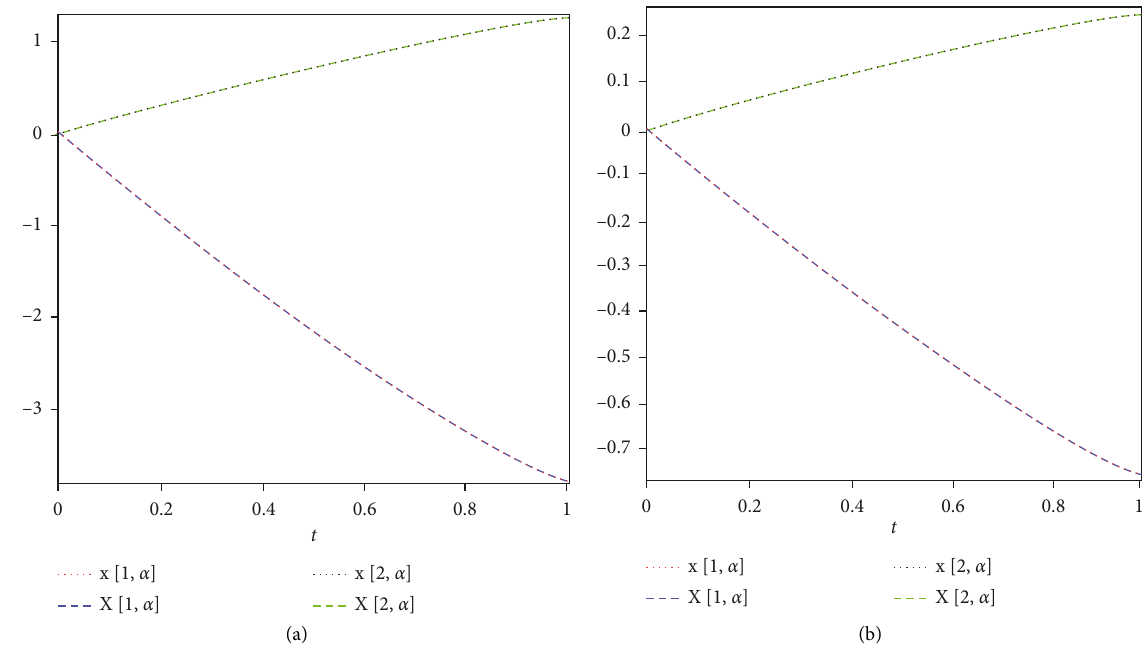
Figure 2: Comparison of the approximate X